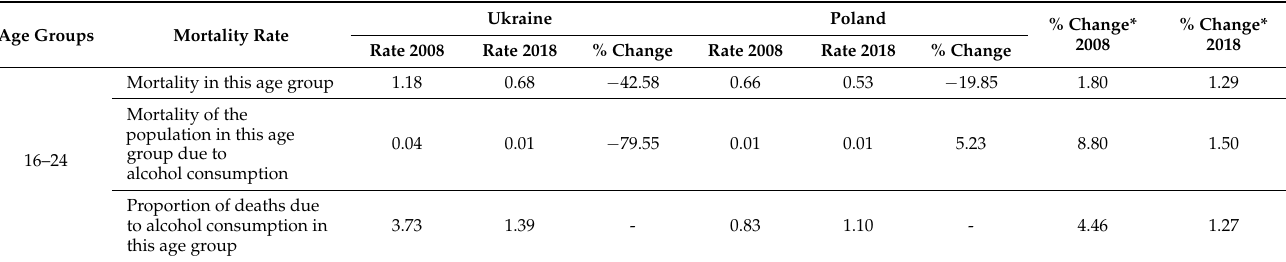
Table 6. Mortality of the working age population by age